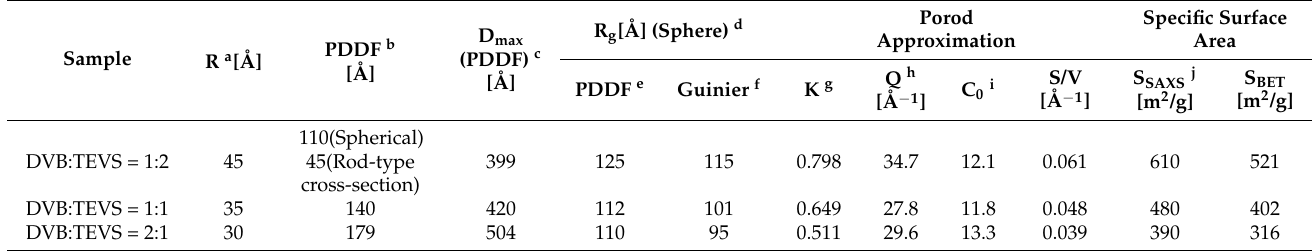
Table 1. Structural parameters of the investigated organic-inorganic systems.